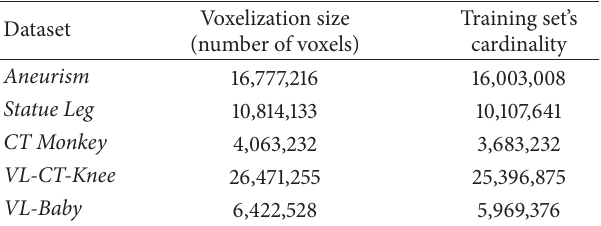
Table 8: Training sets’ cardinalities for voxelizations described in Tables 1 and